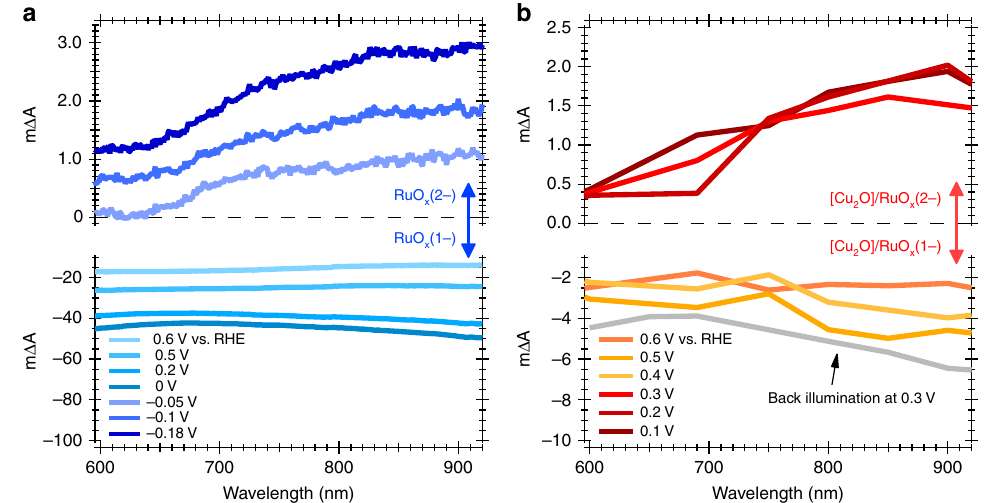
Figure 3 | Spectroelectrochemical spectra at different applied potentials. Spectra showing the changes in absorbance ( D A (cid:3) 10 (cid:2) 3 ) when RuO x ( a ) acts as a dark electrocatalyst and ( b ) is part of a [Cu 2 O] photocathode under irradiation. For the lower box in a , D A is plotted relative to the absorbance spectrum at open circuit potential (OCP ¼ 0.78V); for the upper box, showing D A spectra at potentials negative of the hydrogen reduction current onset potential ( E onset ¼ 0V versus RHE), the spectra are plotted relative to that at this onset potential. For the [Cu 2 O]/RuO x photocathode ( b ), at all potentials D A is plotted as the difference between light on and light off. For reference, the D A with respect to the absorbance at OCP and the simultaneously measured currents for all applied potentials are shown in Supplementary Figs 3 and 4. For both device types, the negative D A signals observed for E 4 E onset are assigned to RuO x reduction to RuO x ( (cid:2) 1), and the positive D A signals observed for E o E onset are assigned to the further reduction to RuO x ( (cid:2) 2) species. For ( b ) the irradiation conditions were B 5-6s (25s for back irradiation), 365nm illumination ( B 1.5mWcm (cid:2) 2 ). See Methods for experimental details.